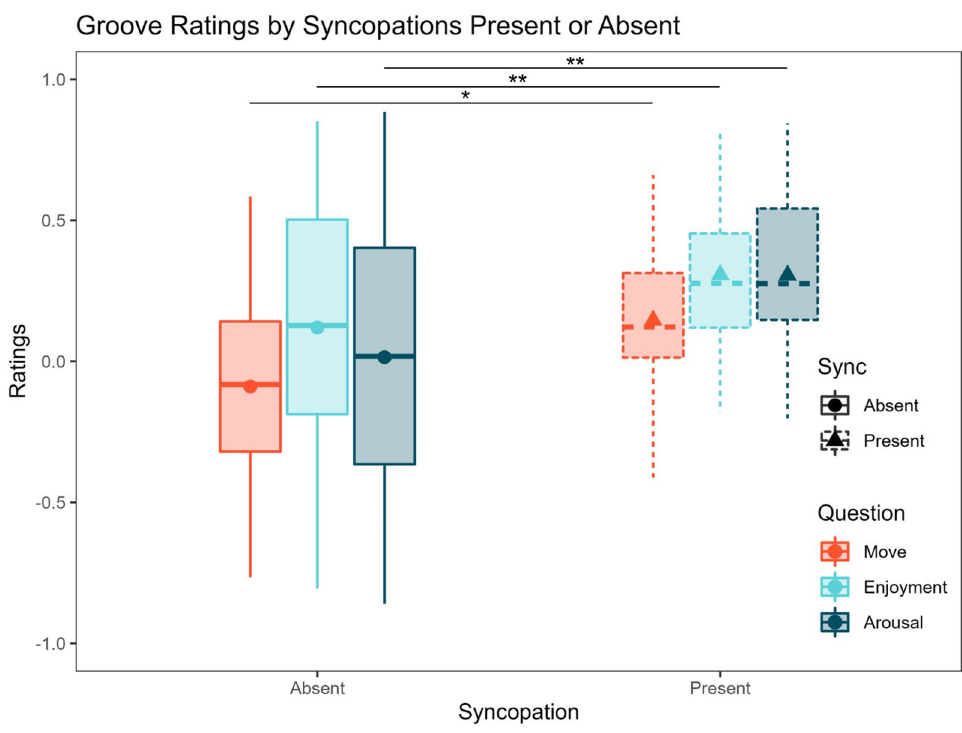
Figure 3. Ratings with pickups (present or absent) and syncopations (present or absent) analyzed orthogonally. The presence of syncopations results in greater ratings of urge to move, enjoyment, and perceived arousal regardless of pickups’ presence. Large dots and triangles represent averages. Single asterisk is p < 0.05, two asterisks p <